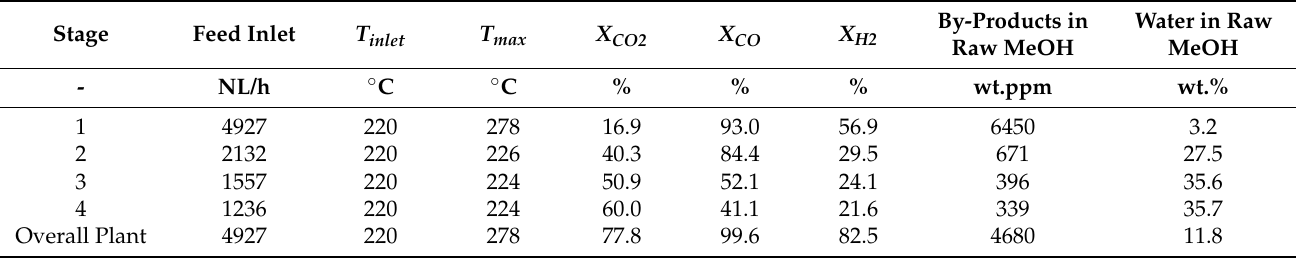
Table 6. Conversion of CO 2 , CO, and H 2 in each stage and for the overall plant at low load (4927 NL/h (2.80 kg/h)) in the four-stage methanol plant (T = 220 ◦ C, p = 80 bar); time of sampling: 2.00 h (start of operation).